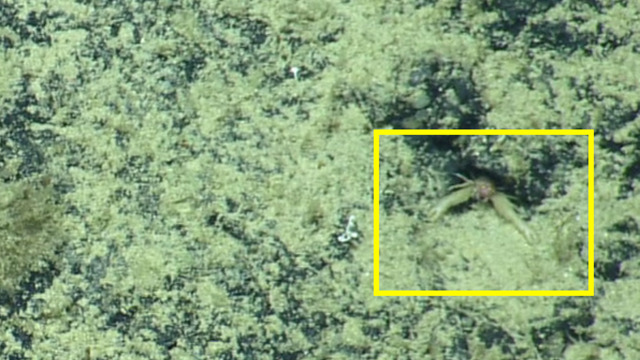
Munida sp. indet. 1